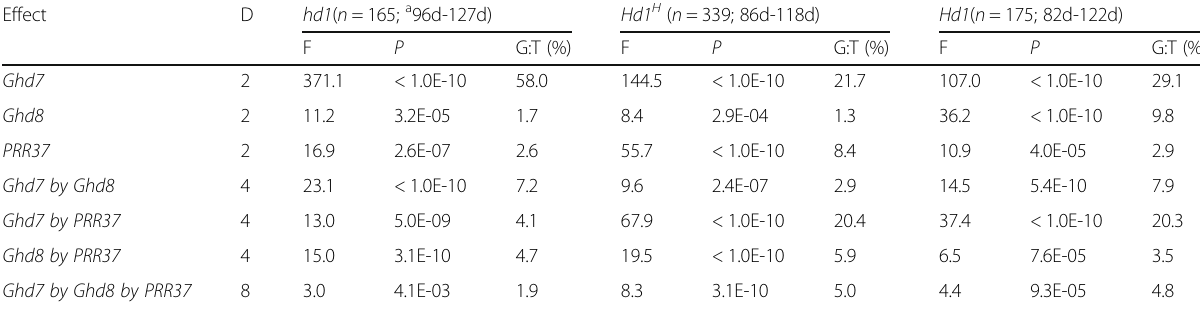
Table 2 Three-way ANOVA analysis of Ghd7 , Ghd8 and PRR37 in NIL-F 3 population under NSD conditions